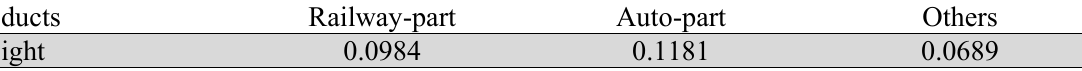
The results of ranking of different